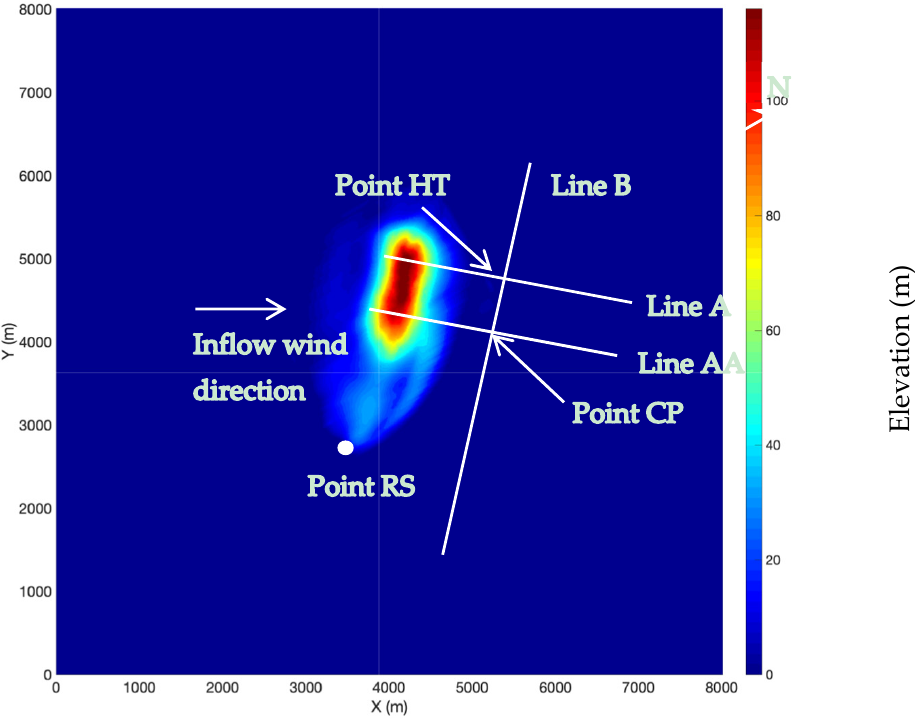
Figure 2. Terrain elevation map of Askervien Hill field study area.